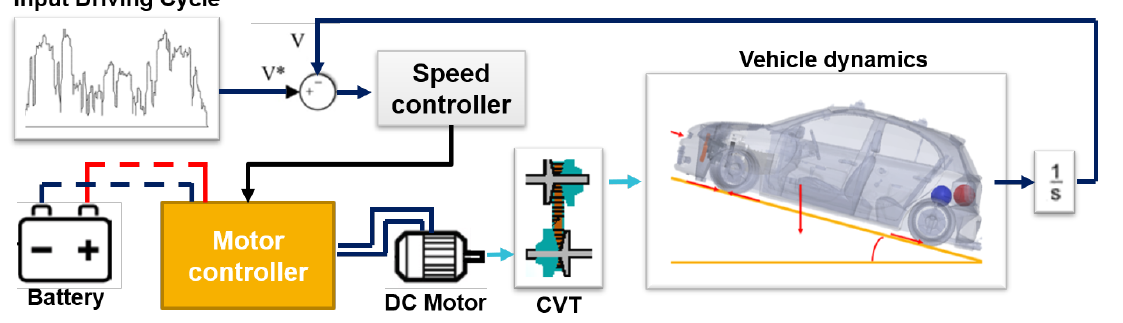
Figure 5. Schematics of the computational simulation model of the EV prototype considering a longitudinal dynamic model and a continuous variable transmission